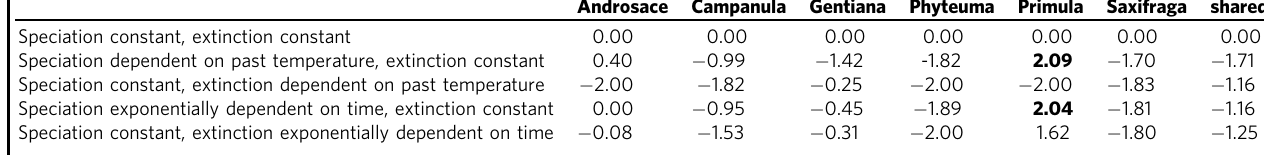
Values with AICdiff>2 are depicted in bold.